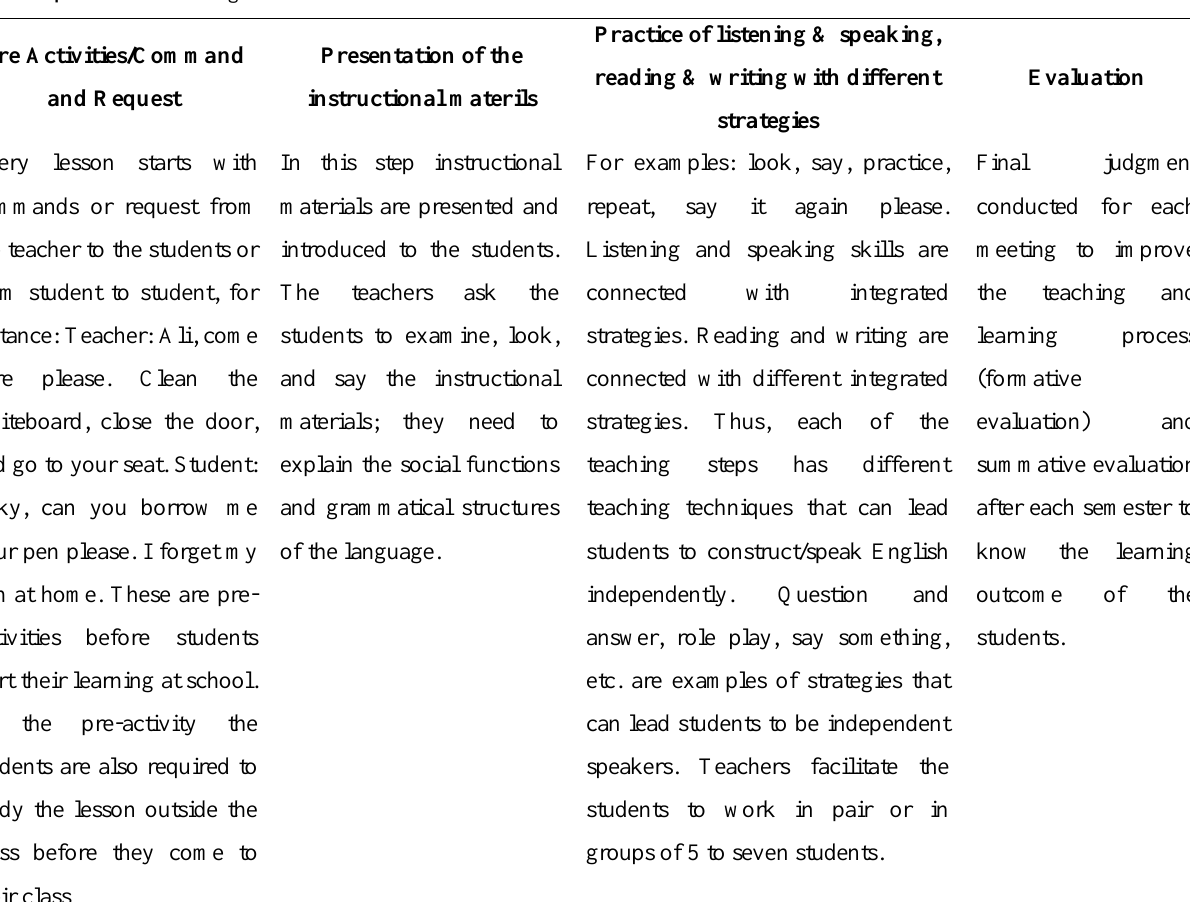
TABLE 6 | The Main Teaching Procedure Pre